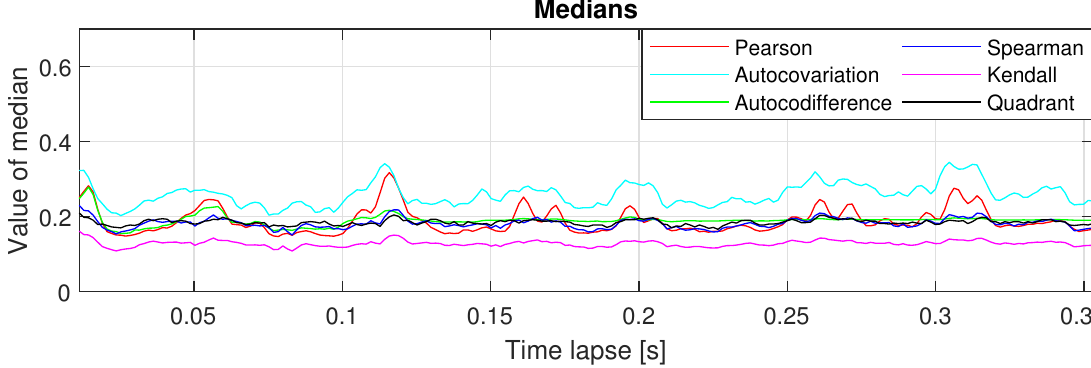
Figure 9. Medians for the frequency band at 3–8.5 kHz. Based on the above presented results, one may conclude that the most reasonable choice between the considered auto-dependency maps is the Spearman and Kendall auto- dependency maps as those which properly indicate the cyclic component and suppress the information about the impulsive